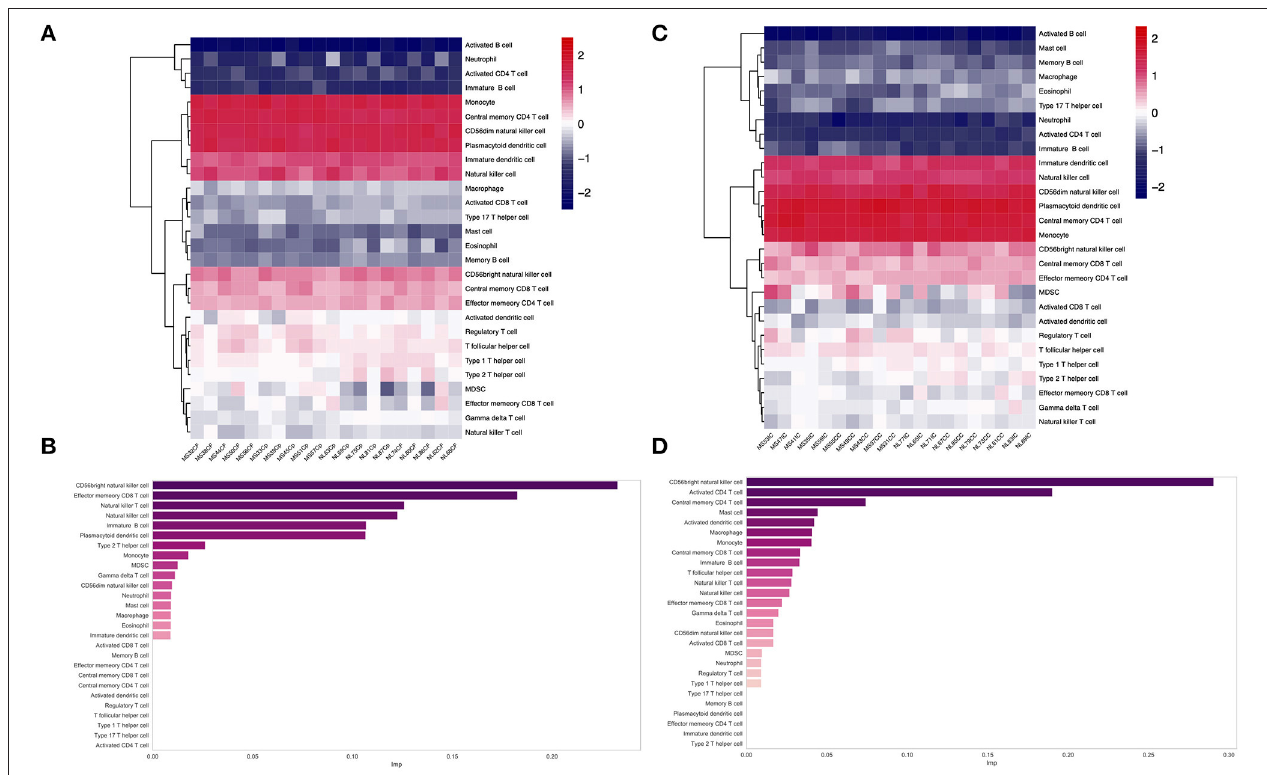
FIGURE 2 | (A,C) Heatmap shows the ssGSEA scores of different gene sets in WM (A) and GM (C) . (B,D) The bar plot shows the relative importance of features (immune infiltration pathway) in the random forest classification model [ (B) WM; (D) GM].